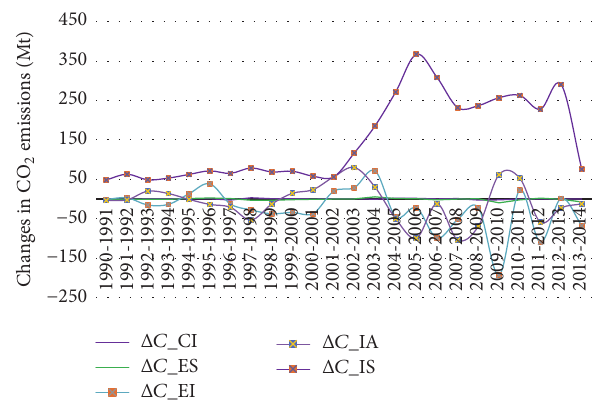
Figure 4: Driving factors to CO 2 emission change by time series in China’s power sector.